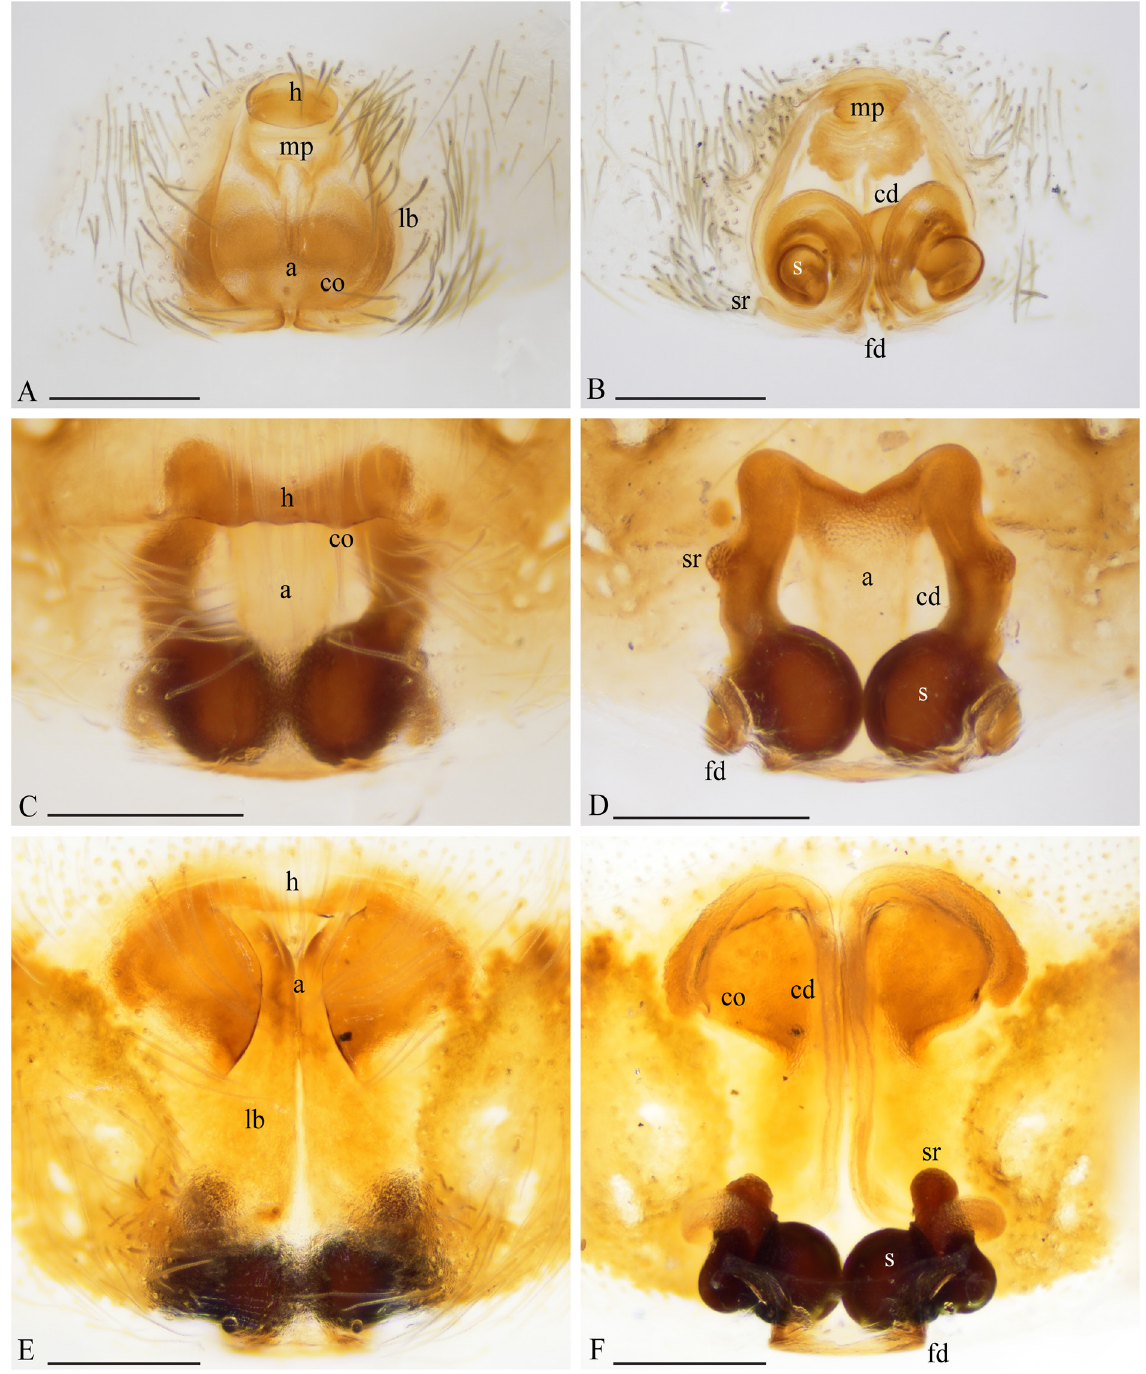
Fig. 2. Anyphaena spp., epigynum anatomies. A–B . A. adnani sp. nov., paratype, ♀ (CNAN-T01546). A . Epigynum, ventral view. B . Epigynum, dorsal view. – C–D . A. rebecae sp. nov., holotype, ♀ (CNAN-T01536). C . Epigynum, ventral view. D . Epigynum, dorsal view. – E–F . A. salgueiroi sp. nov., holotype, ♀ (CNAN-T01537). E . Epigynum, ventral view. F . Epigynum, dorsal view. Scale bars: 0.2